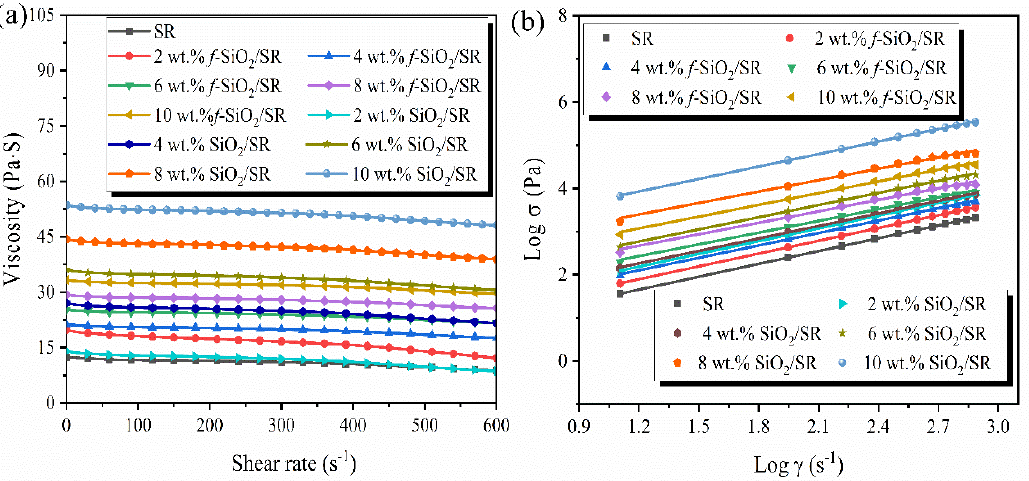
Figure 5. ( a ) Shear viscosity of SR and its composites filled with f -SiO 2 and SiO 2 ; ( b ) relationship between apparent shear rate and shear stress of SR and its composites filled with f -SiO 2 and SiO 2 .